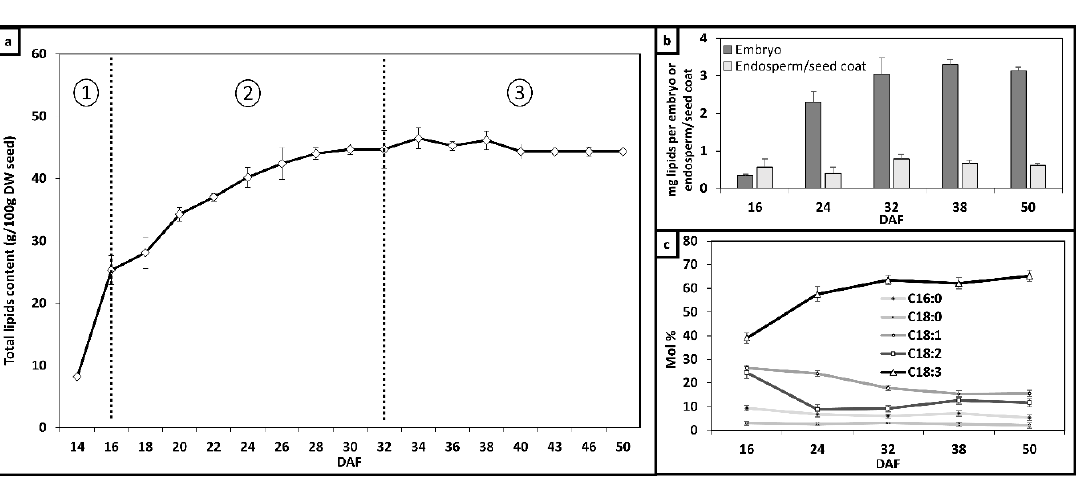
Figure 1. Synthesis of lipids and fatty acids in flax embryos and endosperm/seed coat during seed maturation. ( a ) Total lipid content in flax expressed in g/100 g Dry Weight (DW); ( b ) evolution of total lipids per tissue (mg lipids per embryo or endosperm/seed coat); ( c ) relative fatty acid abundance in embryos during lipid accumulation (mol%). Data is represented as mean and variation ( n =